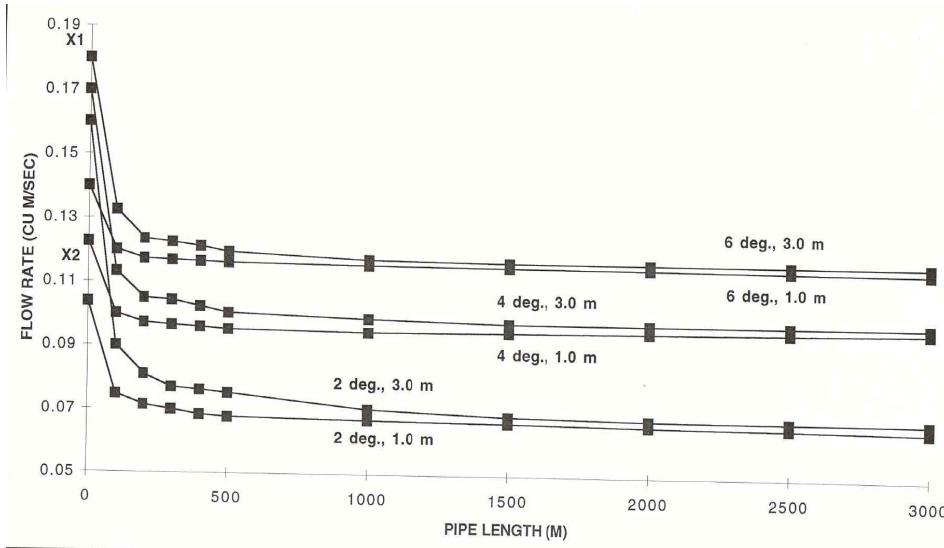
Figure 10. Flow rate in full flow pipelines as a function of supply head (m), pipeline slope (deg.), and pipeline length (M) for a given ε /D value.